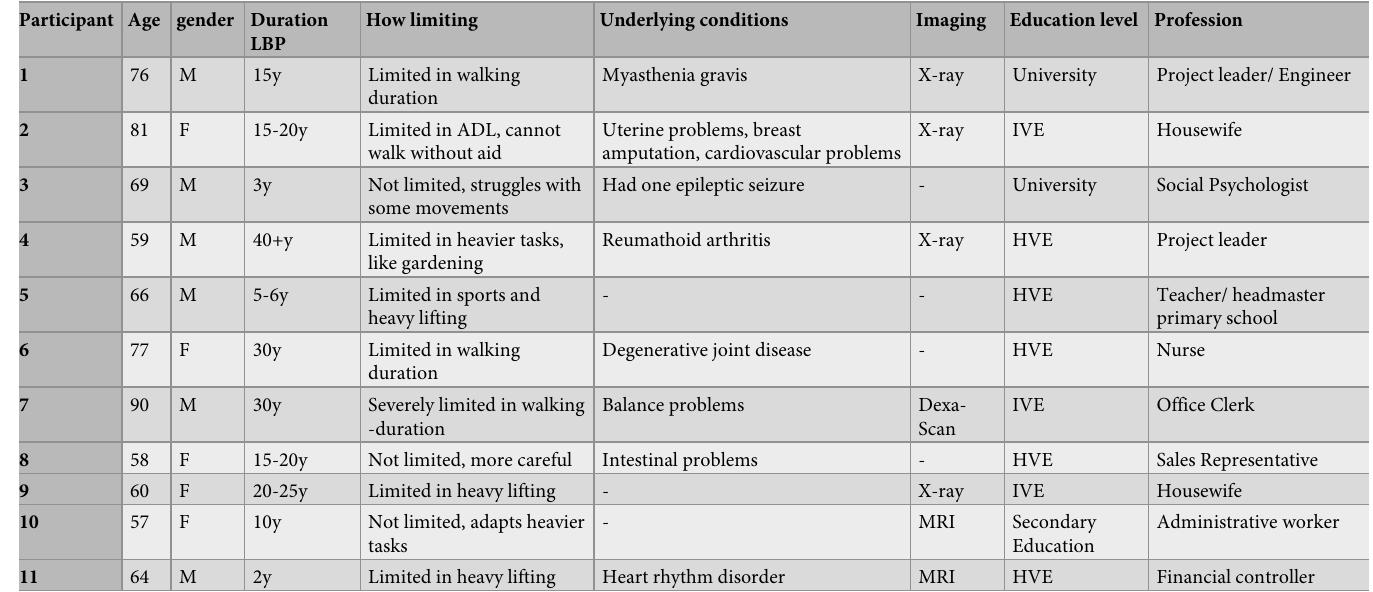
Table 1. Patient characteristics.